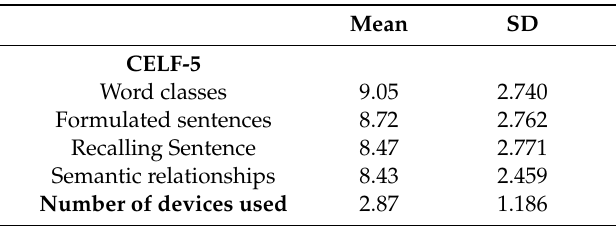
Table 2. Mean scaled scores and standard deviations for language subtests and the number of devices used by the complete sample ( n = 60).